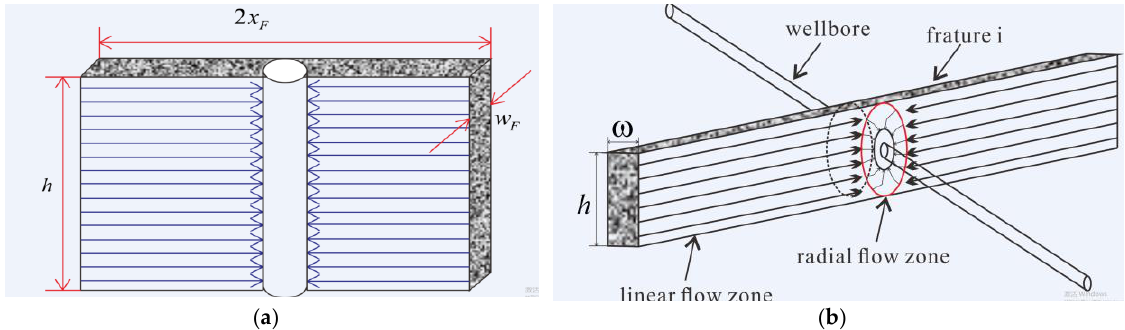
Figure 5. Schematic of porous flow from fracture to wellbore: ( a ) porous flow in one fracture of a vertical well; and ( b ) porous flow in one fracture of a horizontal well.